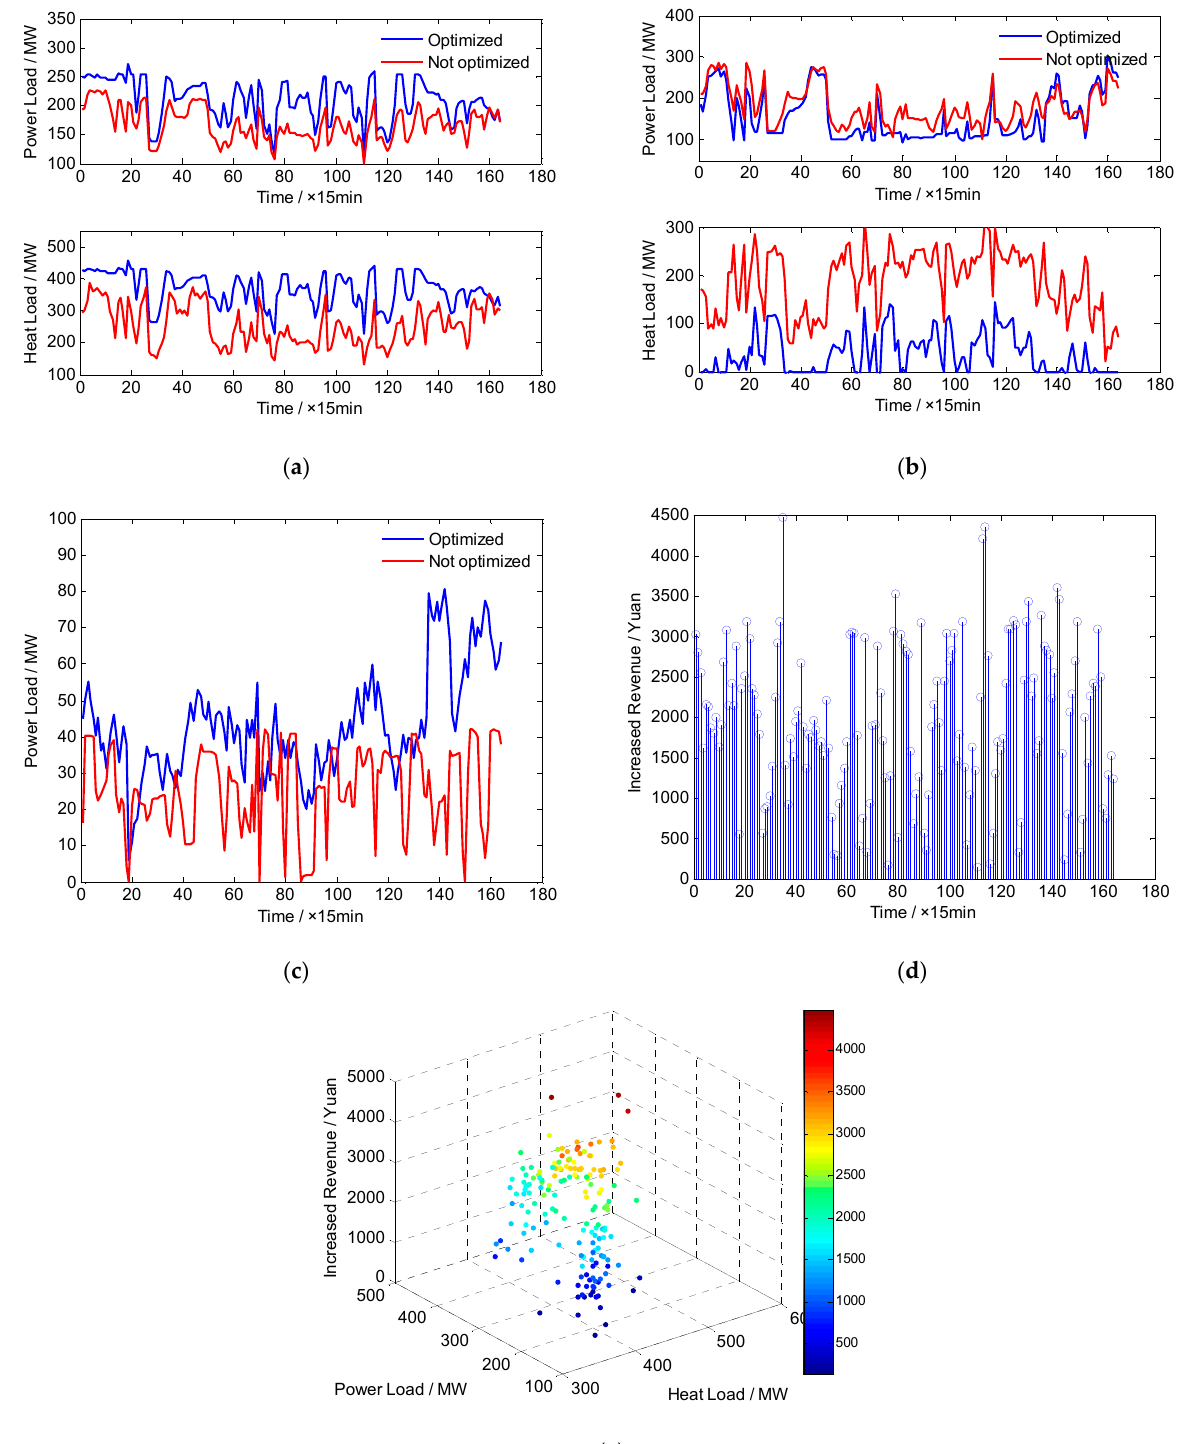
Figure 8. Comparison before and after optimization under mode one (HBP + EH + EB) working conditions. ( a ) Electric and heat load of HBP unit. ( b ) Electric and heat load of EH unit. ( c ) Electric boiler load. ( d ) Coal saving before and after optimization. ( e ) Spatial distribution of cost saving po- tential.